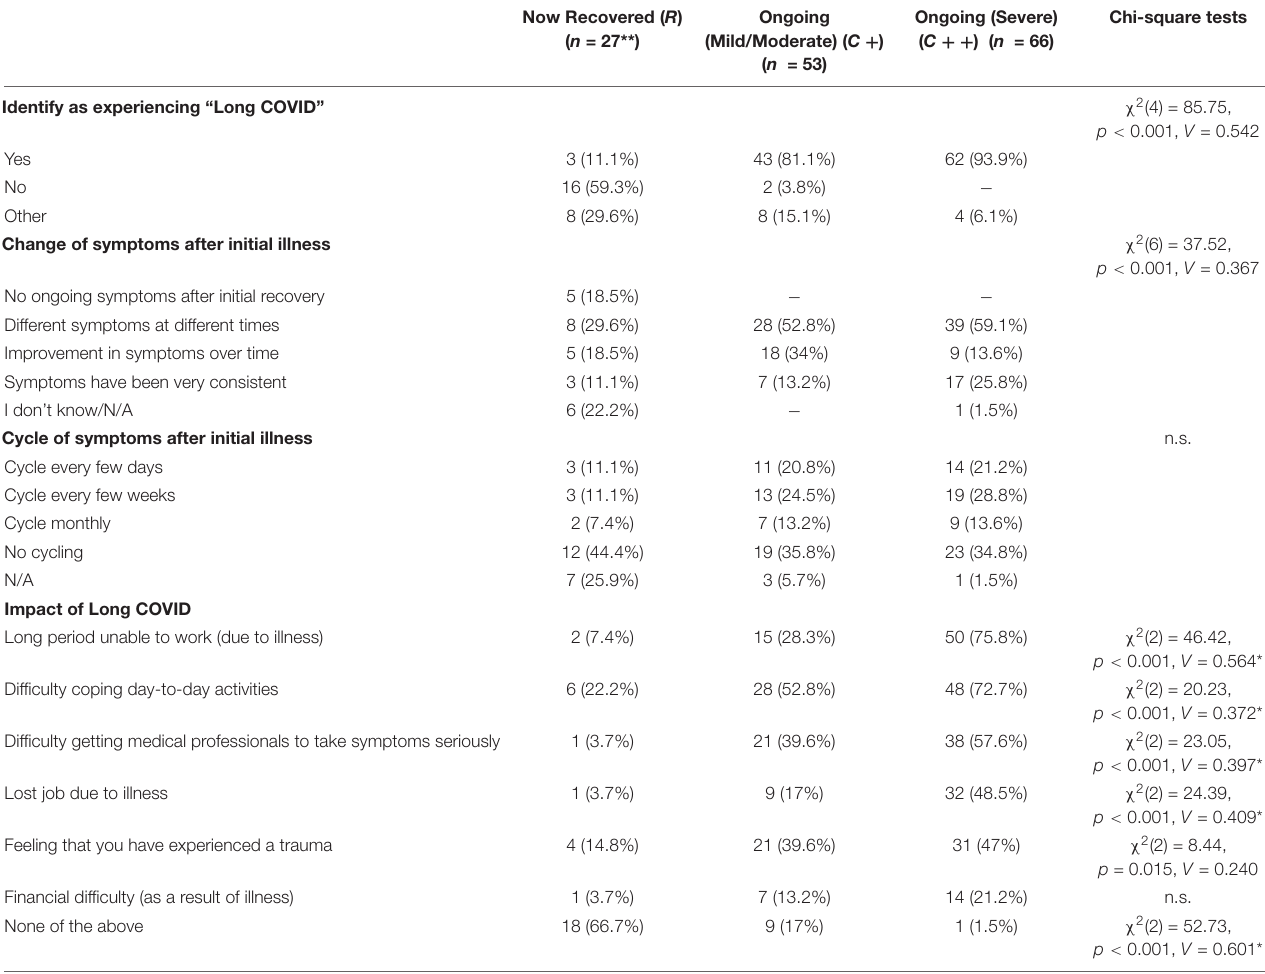
TABLE 6 | Experiences and impact of Long COVID in different ongoing symptom severity groups.